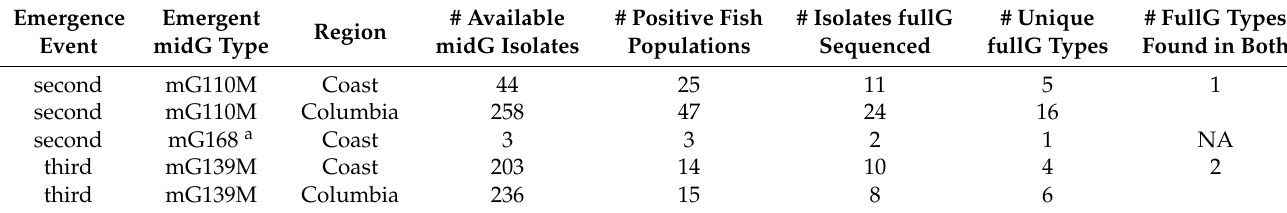
Table 1. Selection of virus isolates for full G gene sequence typing to investigate emergence of subgroup MD IHNV from the Columbia River Basin in coastal Washington steelhead ( O. mykiss ). Isolates associated with the second emergence event of mG110M viruses from the period 2007–2011 and the third emergence event of mG139M viruses from the period 2009–2011 were selected for study, as well as two coastal isolates of mG168M. Available isolates and the number of fish populations they represent from the sink coast region and the source Columbia region were tallied and sub-selected for full G gene sequence typing. The number of unique fullG genotypes found in each isolate set are shown, as well as the number of types detected in both source and sink